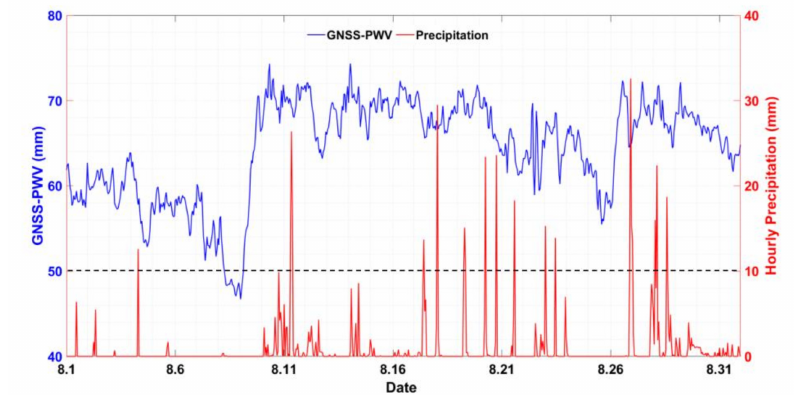
Figure 4. Comparison between GNSS-PWV (blue line) and hourly precipitation records (red line) at the co-located HKSC-KP stations over the 1-month period of 1–31 August 2018. Black dotted line represents a 10 mm / h fixed value defined for heavy precipitation. Figure 4 indicates strong consistency between PWV variation and heavy precipitation